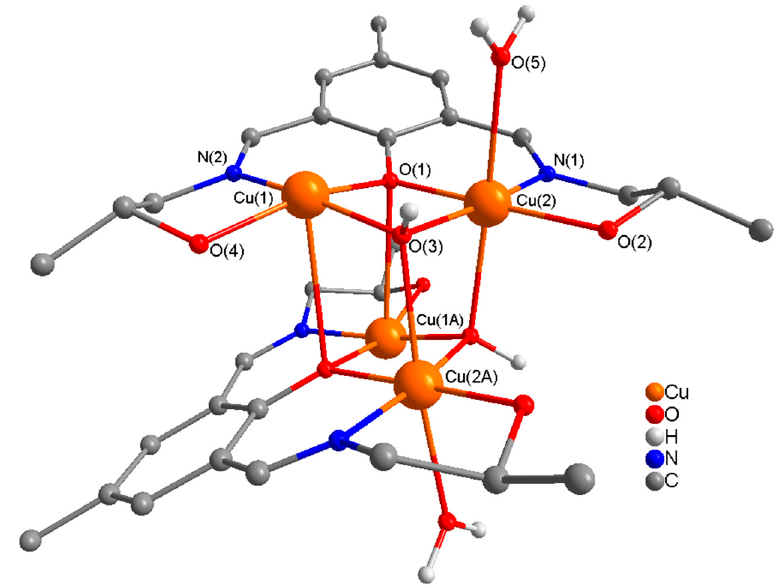
Figure 4. Molecular structure of the tetranuclear unit [Cu 4 (L 3 − ) 2 (OH) 2 (H 2 O) 2 ] ( 2 ) with numbering of relevant atoms in the coordination environment. H atoms and solvent molecules are omitted for clarity. Atoms with A in their labels are symmetry generated.